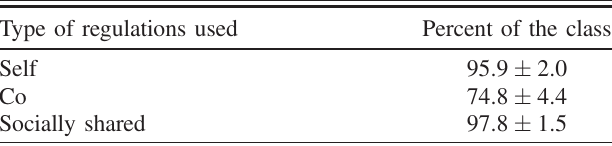
TABLE IV. The percentage of students ( n ¼ 369 ) who reported that they used socially shared, self-, and/or co-regulation on the AIRE survey to overcome their teamwork challenges. The error is given by a 95% binomial confidence